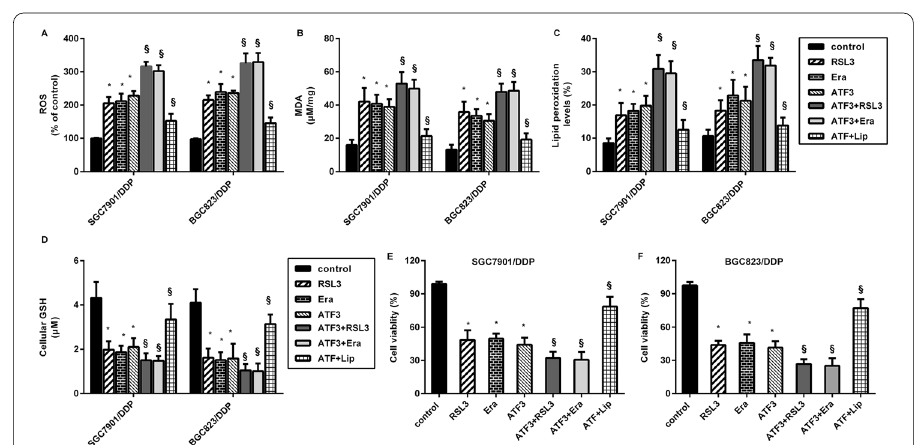
Fig. 4 Ferroptosis was responsible for the effects of ATF3 up-regulation on cisplatin resistance. Cisplatin-resistant GC cells (SGC7901/DDP and BGC823/DDP) were treated with ATF3 transfection, ferroptosis agonist erastin, RSL3 and antagonist liproxstatin-1 under cisplatin conditions. Then, the levels of ROS ( A ), MDA ( B ), lipid peroxidation ( C ) and GSH ( D ) were determined. E , F Cell viability in SGC7901/DDP ( E ) and BGC823/ DD ( F ) was evaluated by CCK-8 assay. * P < 0.05 vs. control group. § P < 0.05 vs. ATF3-treated